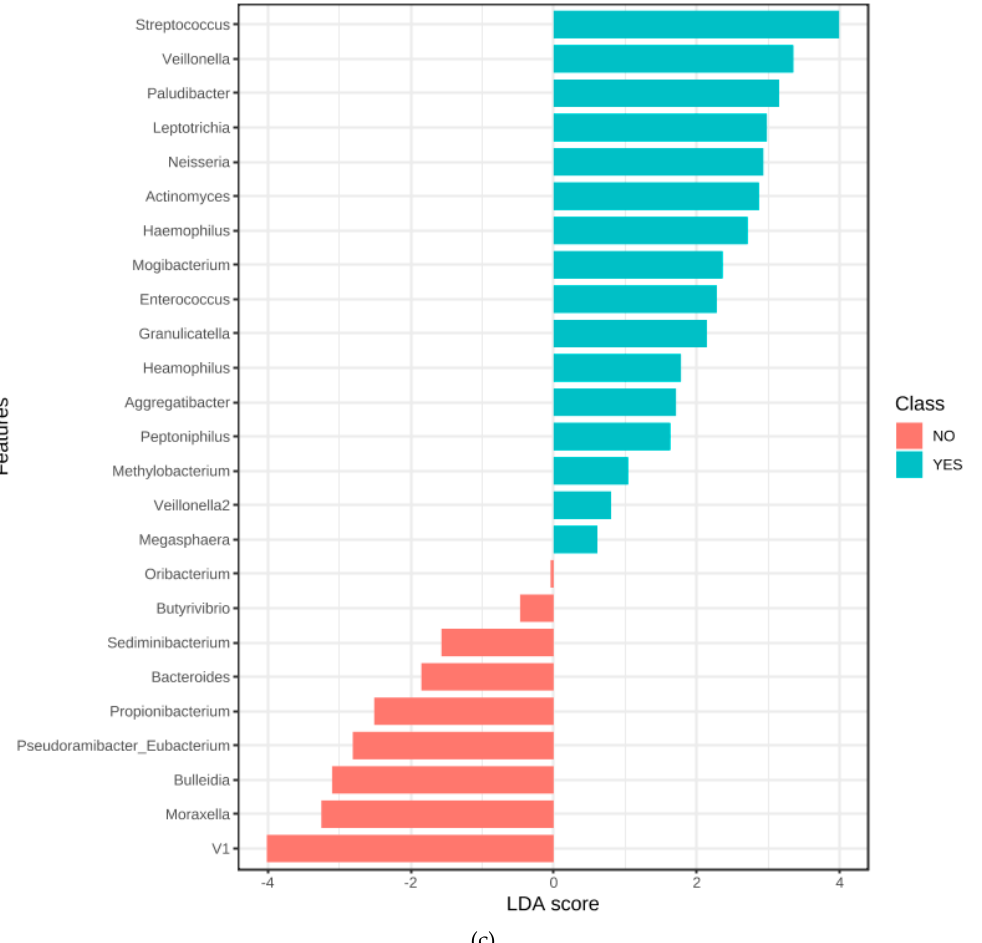
Figure 6. ( a – c ): Correlation of primary (P1–P19) versus secondary (S1–S6) infections and Entamoeba status (Yes/No). ( a ) Multidimensional NMDS plot and ( b ) Jenson-Shannon clustered, phylogenetic chart displaying a core, phylogenetically dense and related cluster of both secondary infections and Entamoeba-positive status. The LefSe enrichment ( c ) of genera demonstrated significant di ff erential enrichment based on Entamoeba